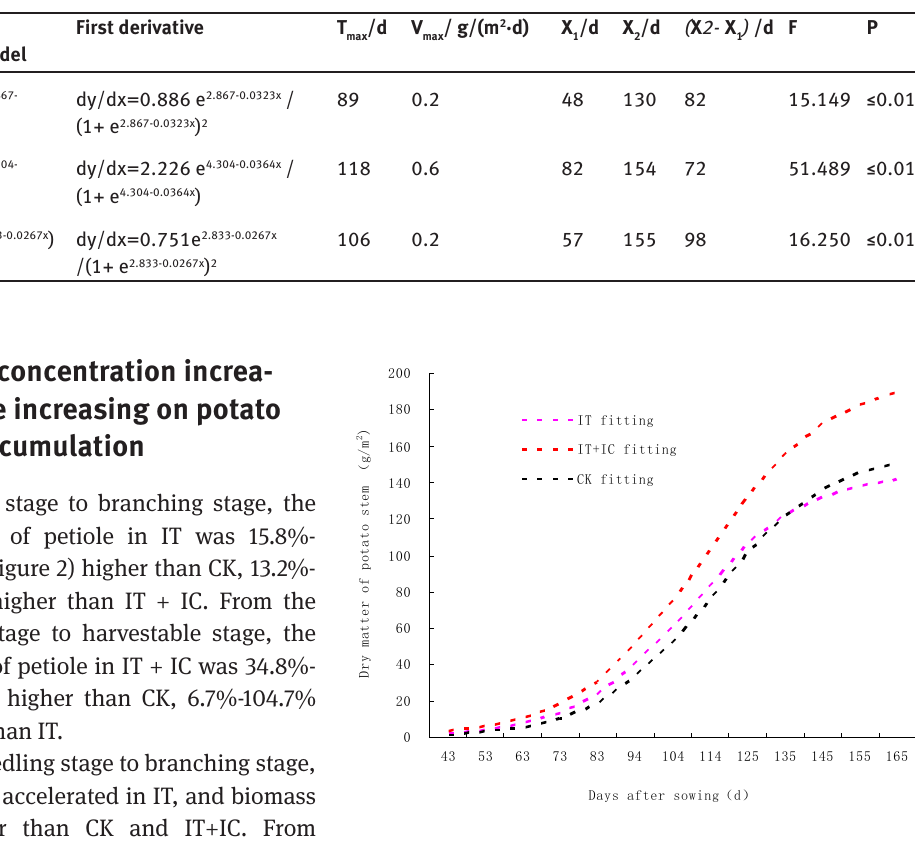
Figure 3: Dynamic simulation curve of dry matter accumulation for potato stem in different